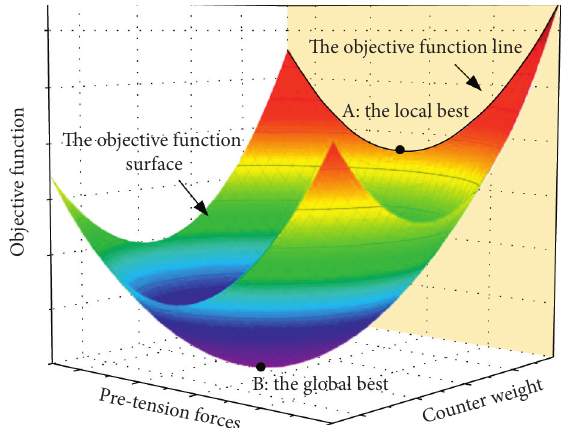
Figure 1: Schematic diagram of